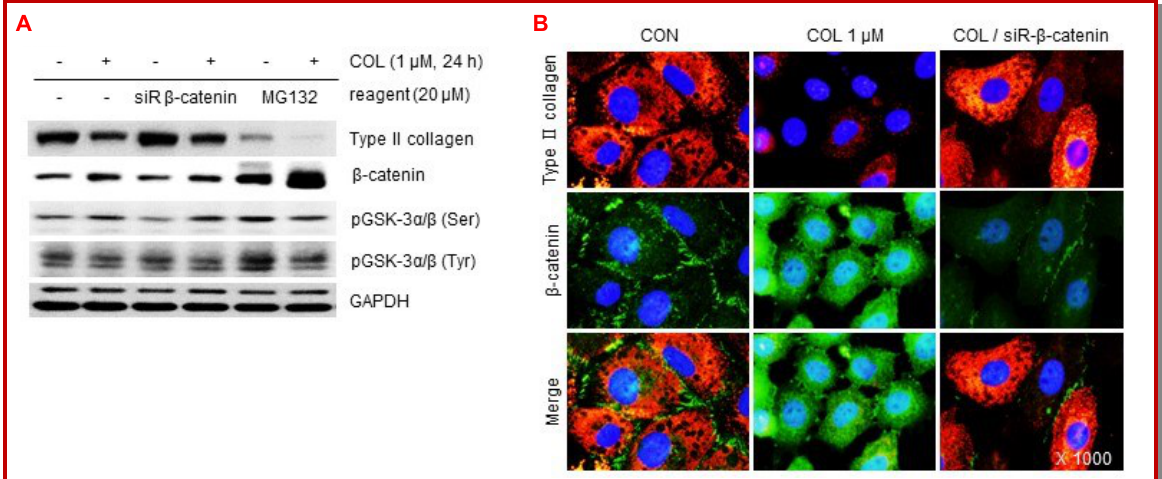
Figure 5: Colchicine causes chondrocyte de-differentiation via regulating the β -catenin pathway (A) Chondrocytes were treated with 20 μ M MG132 for 12 hours before being exposed to 1 μ M colchicine for 24 hours, or they were transfected for 12 hours with either an empty vector or 0.1 μ M siR β -catenin. Western blot analysis was used to find the expression of type II collagen, β -catenin, pGSK- 3 (Ser9/21), pGSK-3 (Tyr216/279), and GAPDH. GAPDH was used as a loading control. (B) Chondrocytes were subjected to 1 mM colchicine for 24 hours after being left untreated or treated for 3 hours with 5 mM TAX. Western blot analysis was used to find expression of pGSK-3 (Ser9/21), pGSK -3 (Tyr216/279), and GAPDH. We used GAPDH as a loading control. (C) Chondrocytes were transfected for 12 hours with either an empty vector or 0.1 μ M siR β -catenin before being subjected for 24 hours to 1 μ M colchicine. Using immunofluorescence labeling, it was possible to measure the expression of type II collagen and β catenin. Cells were labeled with a particular antibody (red or green) and DAPI for nuclear staining (blue). Magni- fication: x400